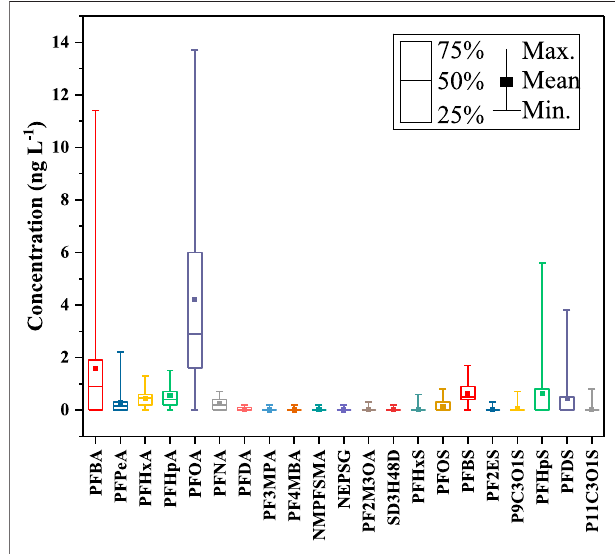
FIGURE 2 | Concentration of PFASs in 7